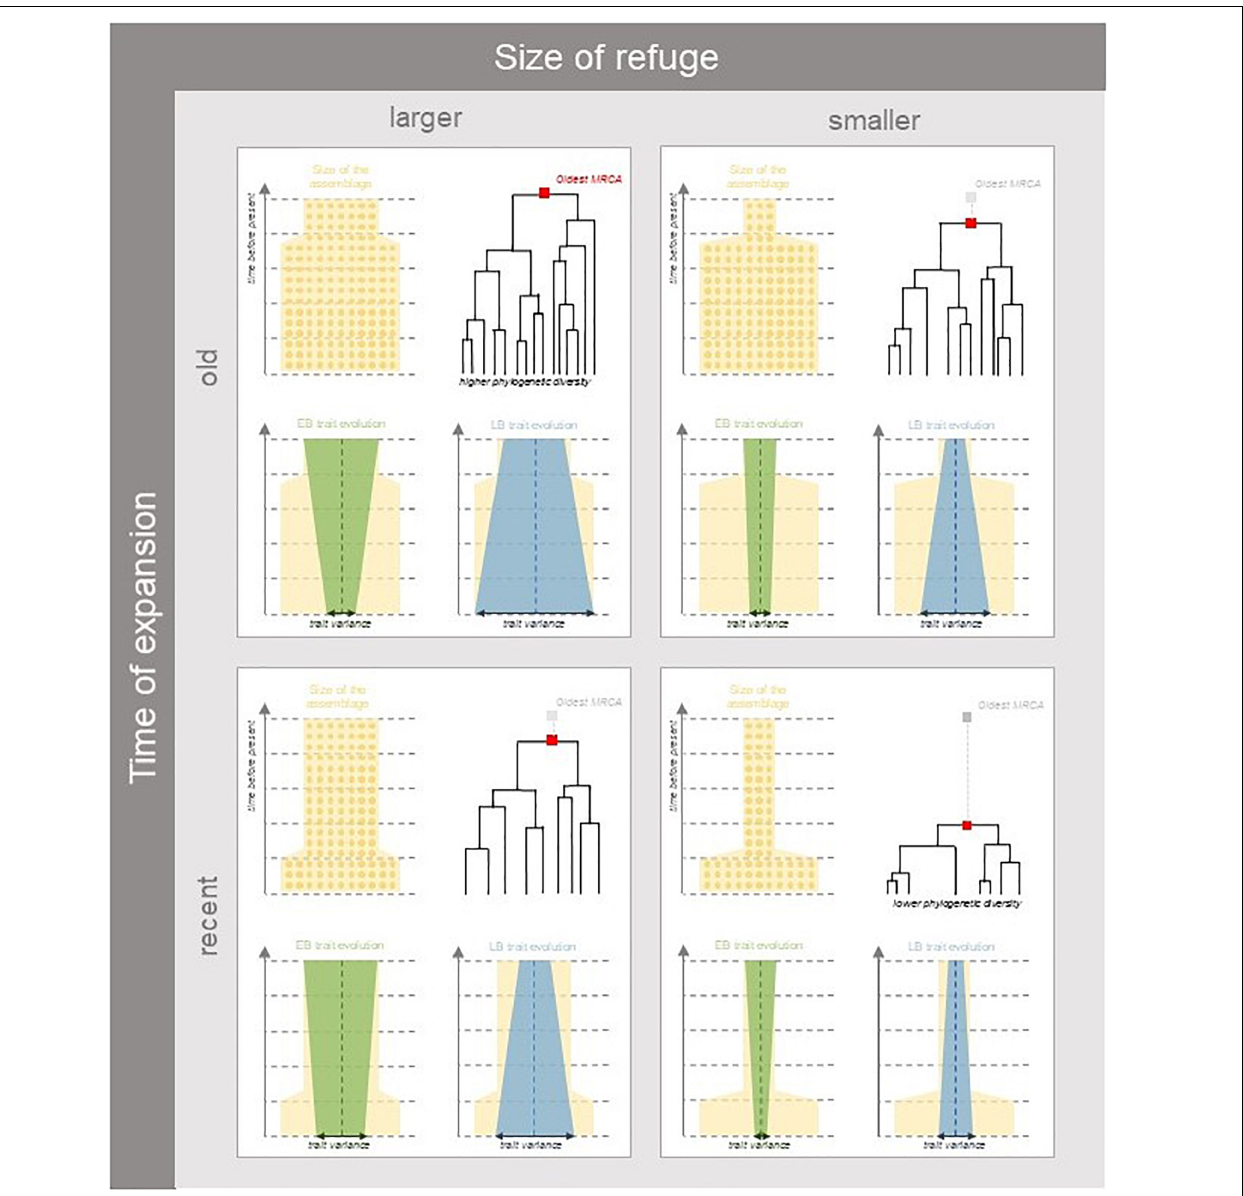
FIGURE 1 | Expected patterns of taxonomic, phylogenetic, and trait diversity under different scenarios of habitat expansion following a period with restricted refugia. Yellow shaded areas represent the size of suitable habitat conditioning the number of individuals over time (represented as circles). The size of the assemblage instantaneously increases at a given time (parameter t c ) so as to represent habitat expansion (parameter A). Current patterns of diversity will depend on how restrictive past habitat sizes were relative to present (left vs. right panels) and how long assemblages have spent in refugia (top vs. bottom panels). In larger refugia lower extinction rates allow more species in older lineages to persist in extant assemblages, while in smaller refugia more species will be lost to the increased influence of drift. Functional diversity will depend on the pace and timing of trait evolution in relation to diversification events. Trait evolution can deviate from the ancestral trait values (vertical dashed lines), and can experience exponential deceleration (Early Burst—EB represented in green) or acceleration (Late Burst—LB represented in blue), the resulting patterns of functional diversity will depend of whether acceleration or deceleration of trait evolution happens in or out of refugia. For example, if greater trait evolution occurs during strong habitat restriction, trait diversity among descendant lineages would be